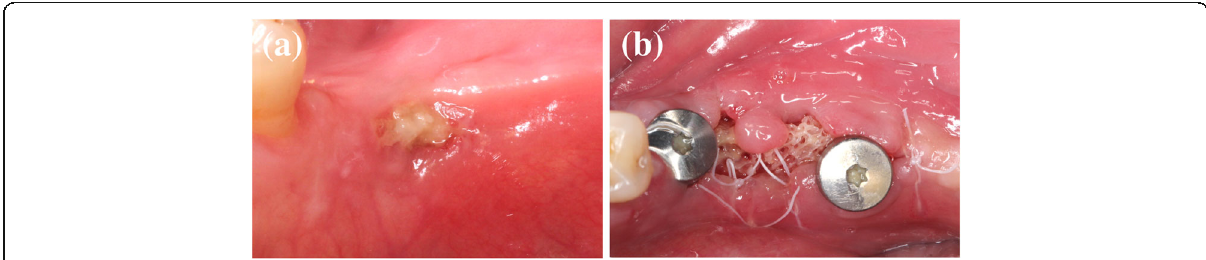
Fig. 8 Soft tissue dehiscence ( a ) CCXBB exposure 15 weeks after bone augmentation, the dehiscence healed 2 weeks later after reducing the graft exposure ( b ) after soft tissue augmentation and abutment connection leading to the loss of the mesial implant. After partial removal of the bone graft and place a connective tissue graft the area healed properly and a month later it was possible to replace the